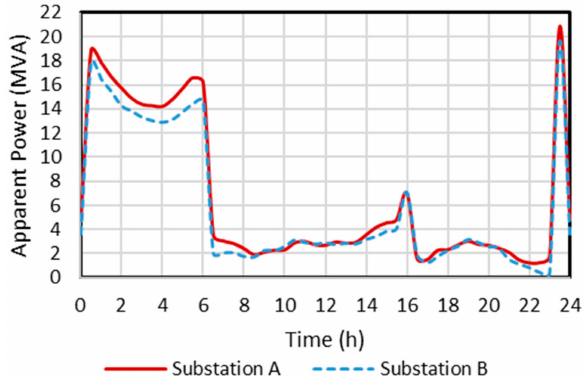
Figure 10. Apparent power flows through transformers after the introduction of DR scheme for scenario